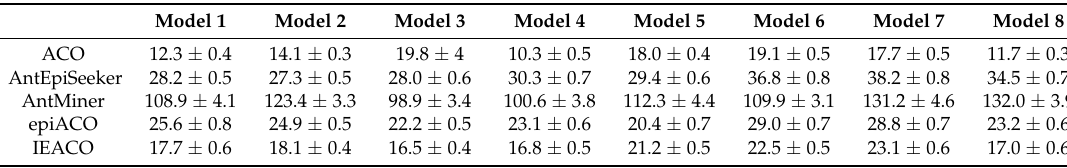
Table 7. Results of running time on 500-SNP datasets.